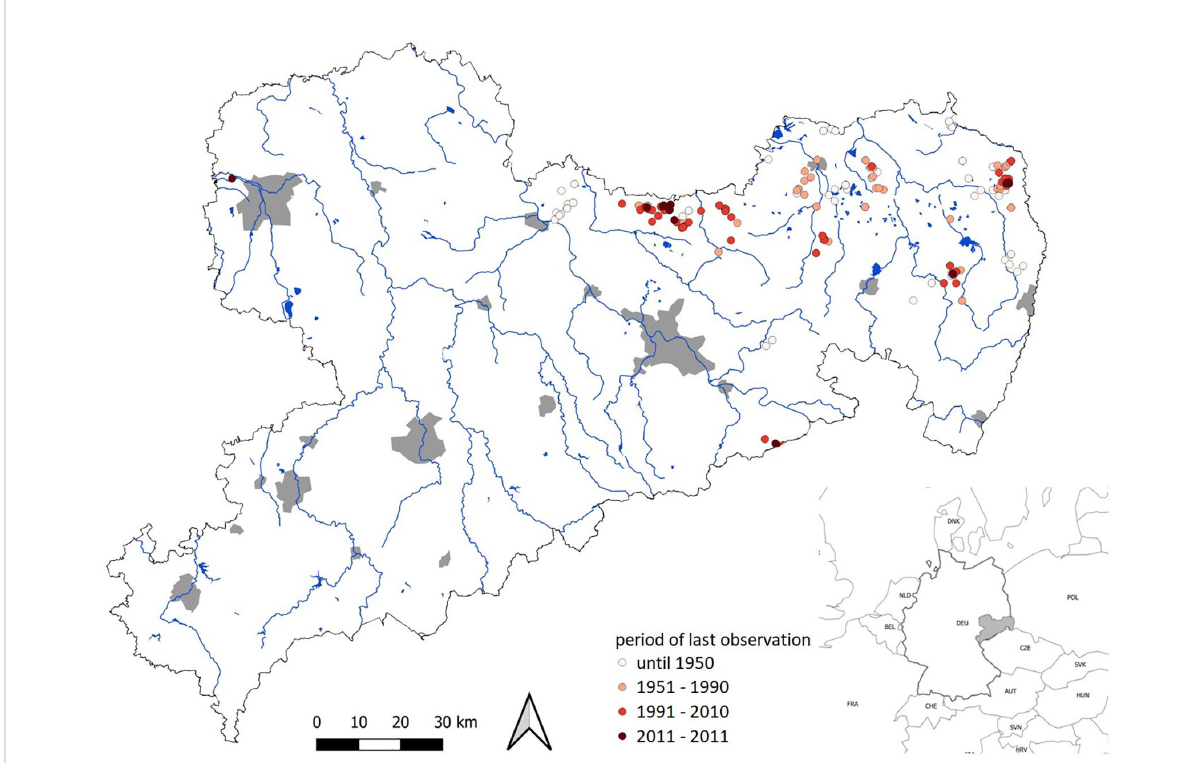
FIGURE 1 Occurrences of Luronium natans in Saxony (Germany) based on records from herbaria in Dresden (DR), Görlitz (GLM), Halle (HAL), Jena (JE) and Leipzig (LZ). Main rivers and water reservoirs are marked in blue, cities in